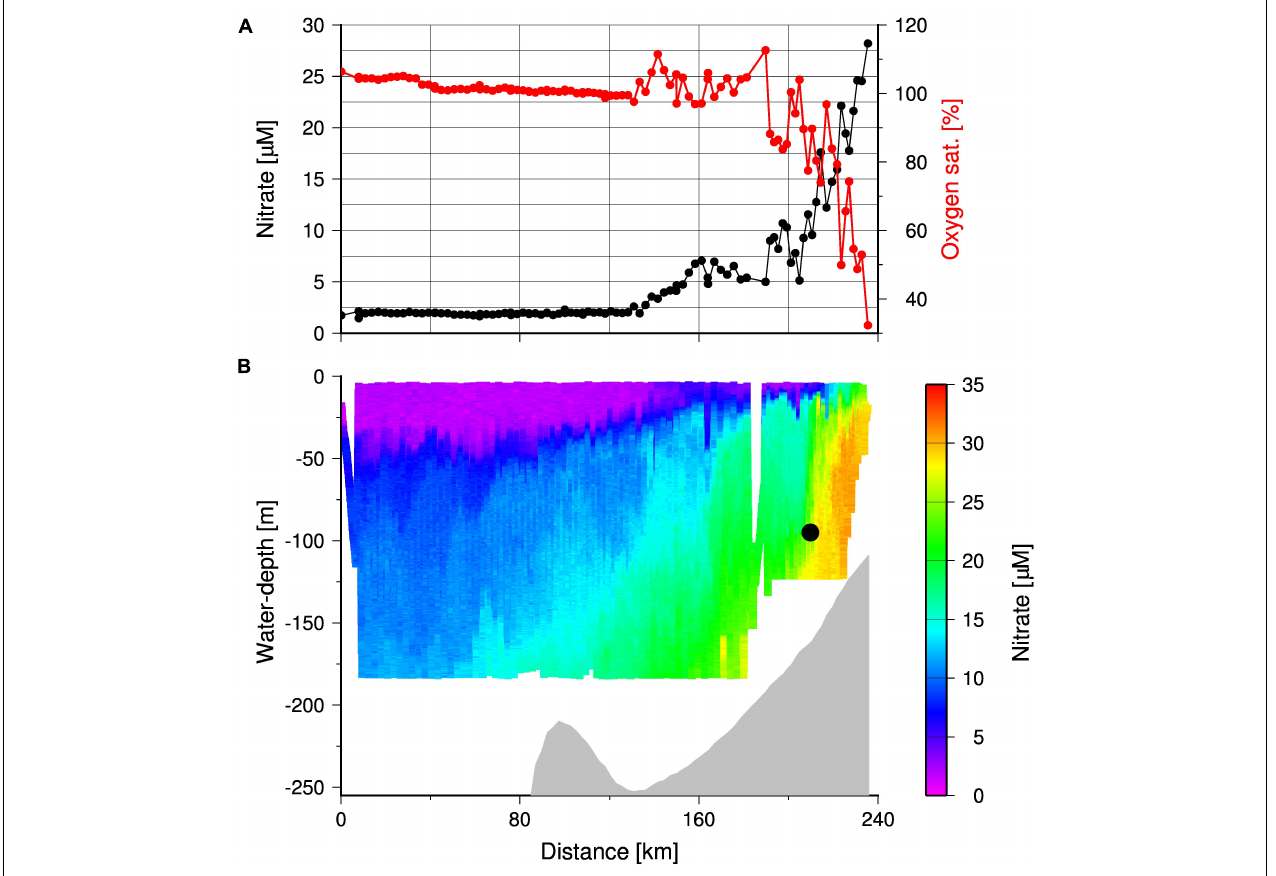
FIGURE 11 | (A) Oxygen saturation and nitrate concentrations in surface waters (water-depth < 10 m) and (B) TRIAXUS transect showing the cross-shelf distribution of nitrate in the entire water column down to water-depth of 180 m. The gray shading indicates the bottom and the black circle indicates the position of the MDO